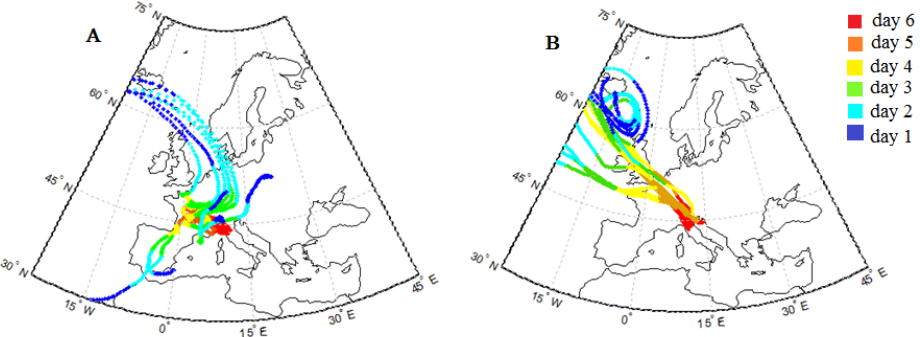
Fig. 2. Member of the back-trajectory ensembles travelling over the “Iceland” box for the two major events: 19–21 April (A) and 18– 20 May 2010 (B). The different colours identify the day of transport, starting from the source on day 1 and ending at CMN on day 6. Figure 2. Member of the back-trajectory ensembles travelling over the “Iceland” box for the 3 Table 1. Peak values and average and standard deviation for particle number concentrations (accumulation mode, coarse mode and total number), scattering and absorption coefficient, concentration of major inorganic ions and water soluble organic carbon (WSOC) at CMN two “major” events April 19-21 (A) and May 18-20, 2010 (B). The different colours identify 4 during the two volcanic events and as average calculated during April and May over a 5 yr reference period. Accumulation and coarse particle the day of transport, starting from the source at day 1 and ending at CMN at day 6.5 number concentrations are averaged on a 30min basis, particle total number concentration and scattering/absorption coefficients on a 60min time basis. Event